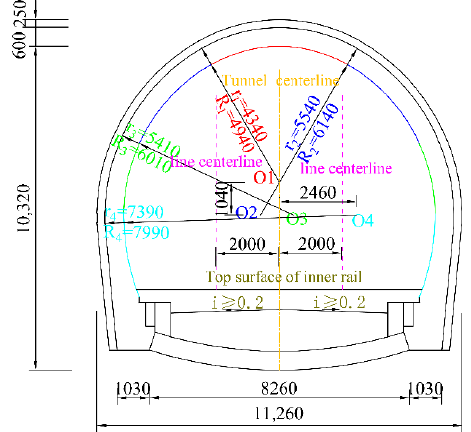
Figure 2. Design lining sectional drawing of grade- Ⅴ surrounding rock (units: